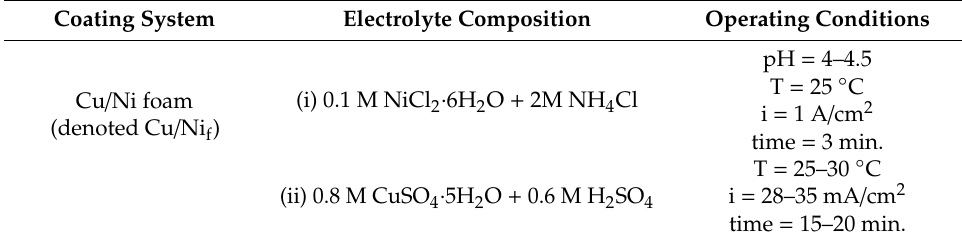
Table 1. Electrolytes composition and operating conditions for electrochemical preparation of the 3D Cu nanoporous